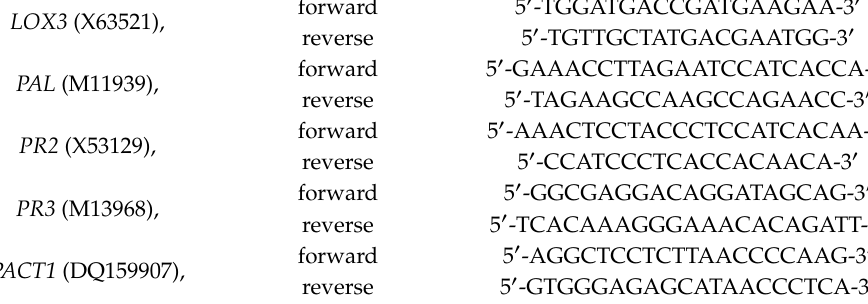
Figure S1: Workflow for determination of OS amount left at the leaf wounding edges, Figure S2: Comparison of fluorescence signals left in plant wounded sites by insects injected with fluorescent dye, Figure S3: SpitWorm set-up and flow rate optimization, Figure S4: Standard curve of fluorescence signal intensity of di ff erent dilutions of Lucifer Yellow solution (1 mg · mL − 1 ), Table S1: Retention indices, and comparison of relative amounts of headspace volatiles upon di ff erent treatments, and Table S2: Dimensions of larval